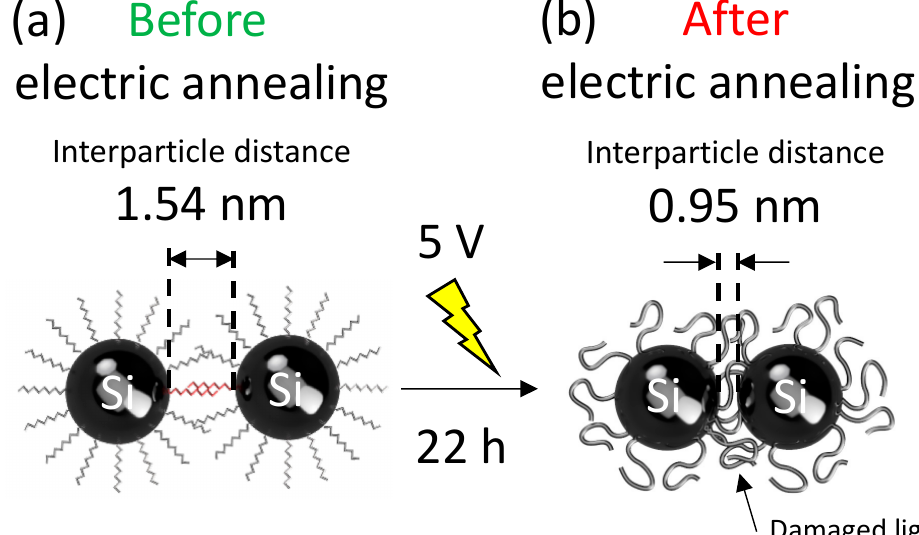
Figure 5. Schematic representation of electric-annealing mechanism in SiQDs layer at ( a ) before and ( b ) after electric-annealing state.